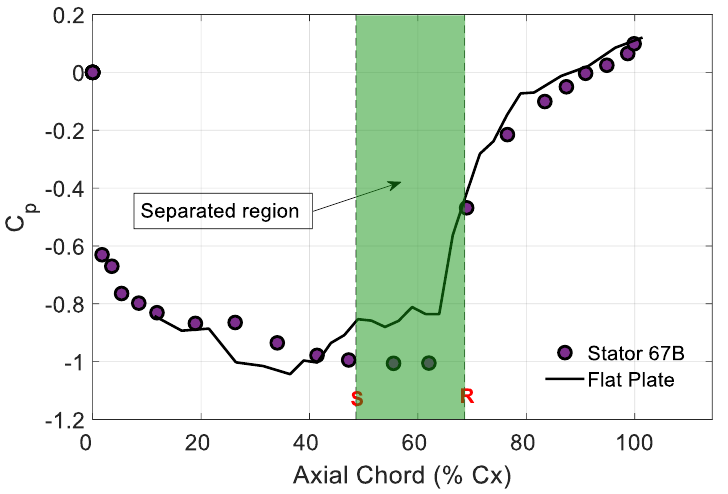
Figure 2. Measured non-dimensional surface pressure ( 𝐶𝑝 ) distribution over the plate. The black line represents data from the current measurements whereas the filled symbols correspond to Stator 67B data from Hobson et al. [16]. S and R represent the approximate locations of flow separation and reattachment from the current measurements.